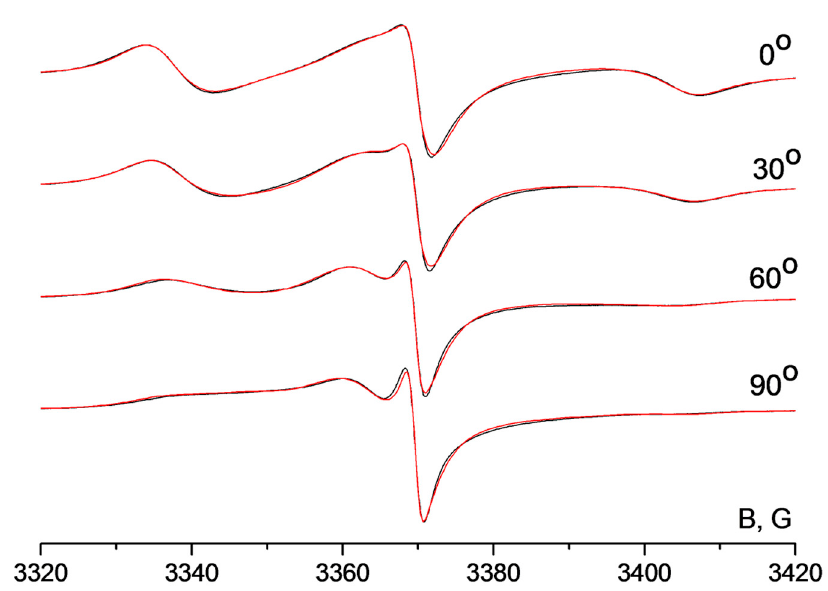
Figure 5. EPR spectra of the membrane including H1; the spectra were recorded at different angles between the membrane surface normal and magnetic field. Black lines—experimental spectra, red lines—result of simultaneous simulation of the spectral series.